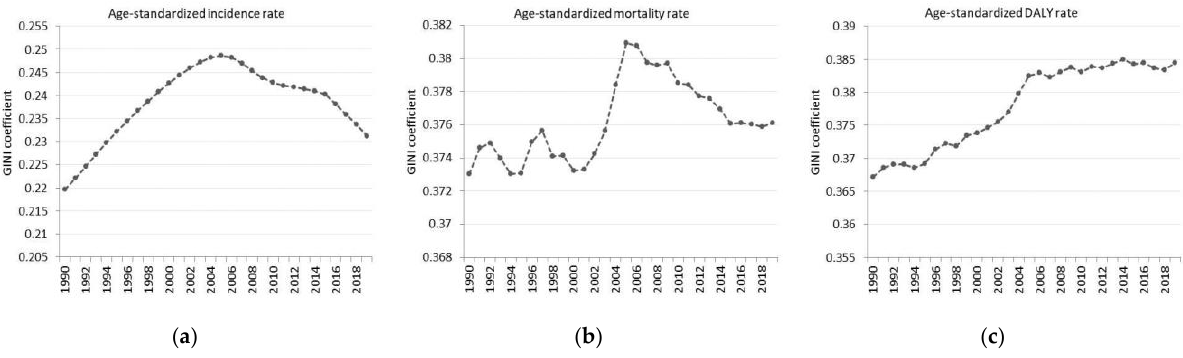
Figure 3. Trends in the Gini coefficients calculated based on ( a ) age-standardized incidence rates, ( b ) age-standardized mortality rates, and ( c ) age-standardized DALY rates across 204 countries globally between 1990 and 2019.